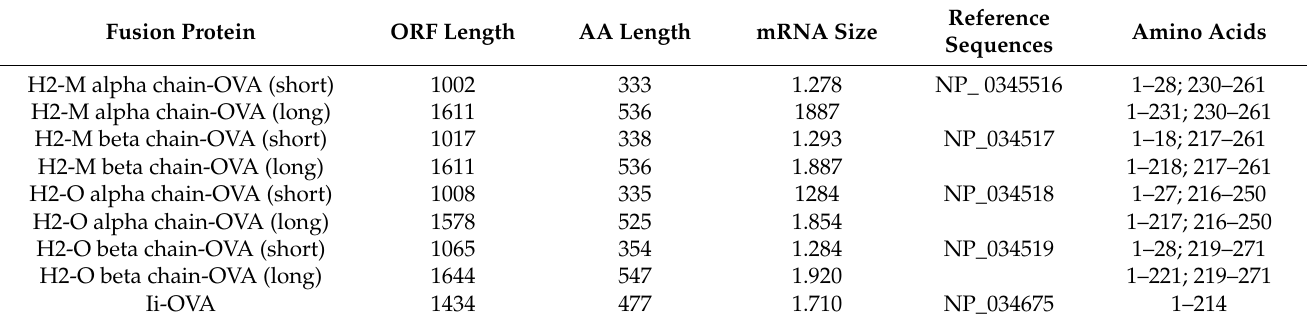
Table 1. Fusion proteins used for murine T cell activation assays. Overview of the protein sequences selected for the study. Fusion Protein ORF Length AA Length